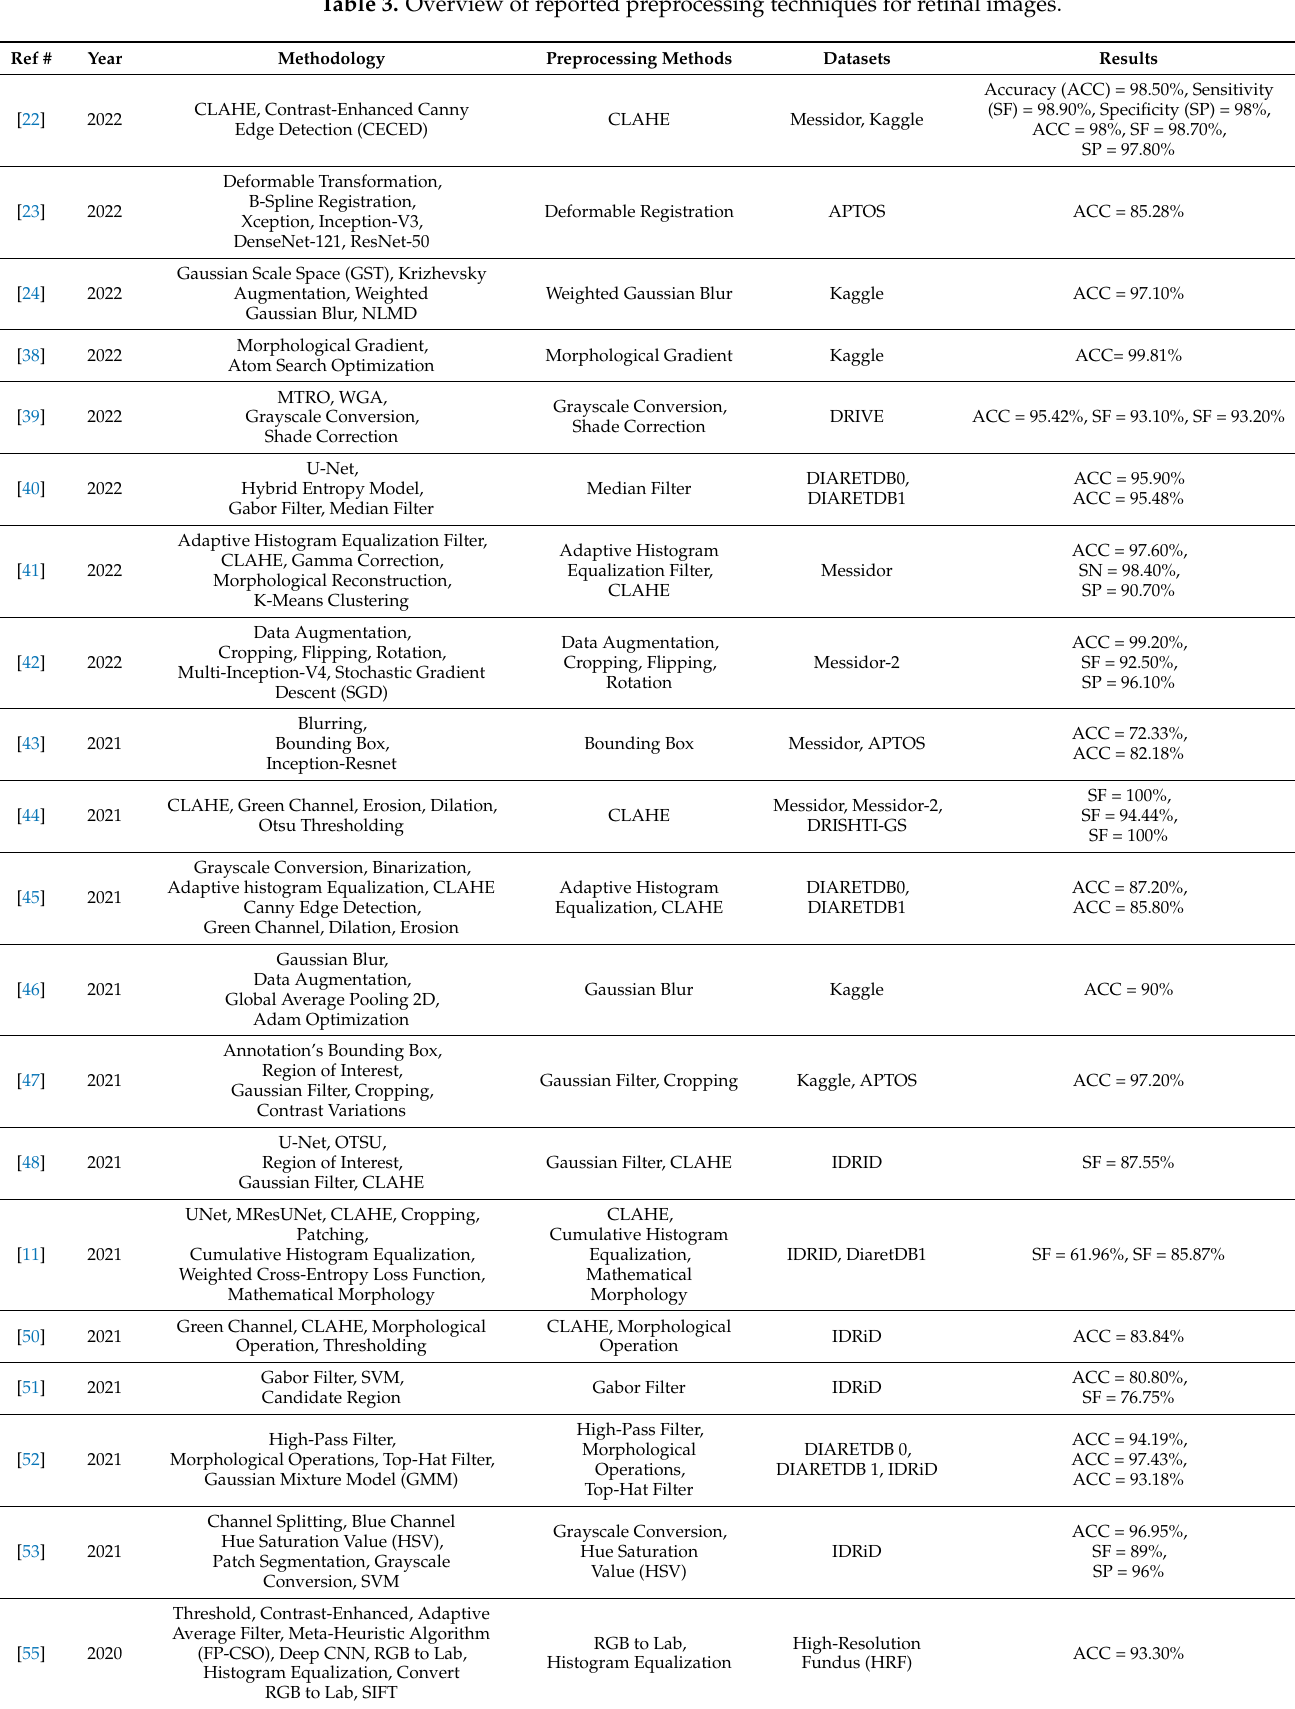
Table 3. Overview of reported preprocessing techniques for retinal